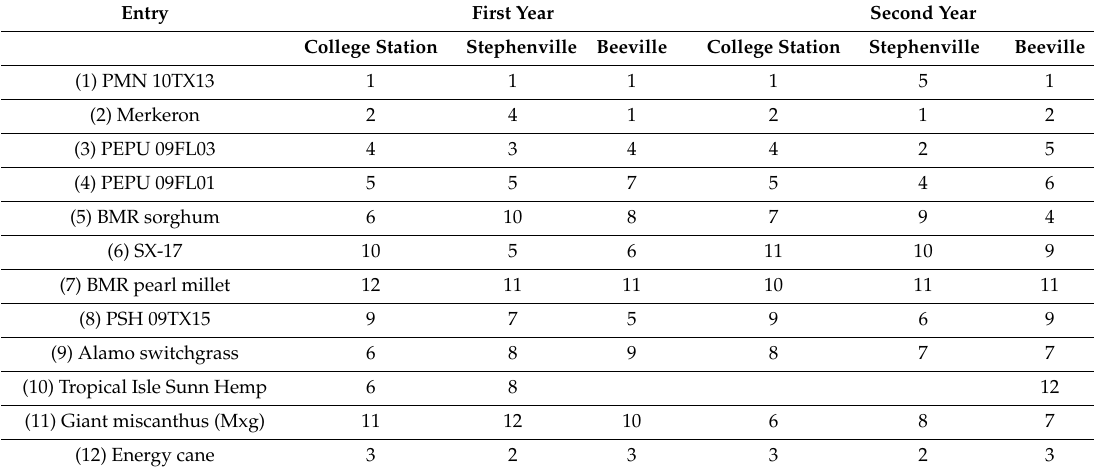
Table 9. Summary ranking of potential biorefinery (bioethanol, biopower, biosilica) across twelve candidate feedstocks based on biomass (highest cellulose and hemicellulose, lowest ADL) and silica yields (kg ha − 1